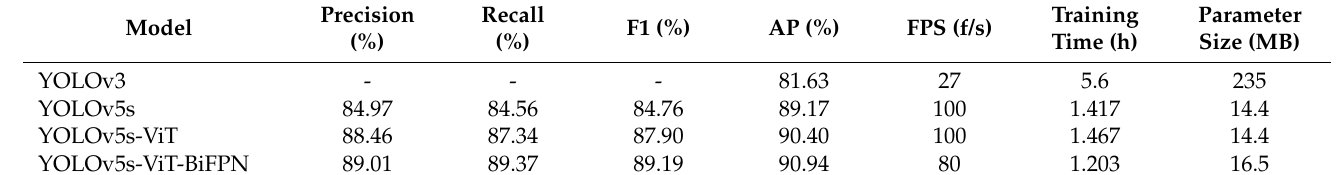
Table 1. The comparison for the performances of the four models based on the metrics Precision (%), Recall (%), F1 (%), AP (%), FPS (f/s), Training Time (h), Parameter Size (MB).